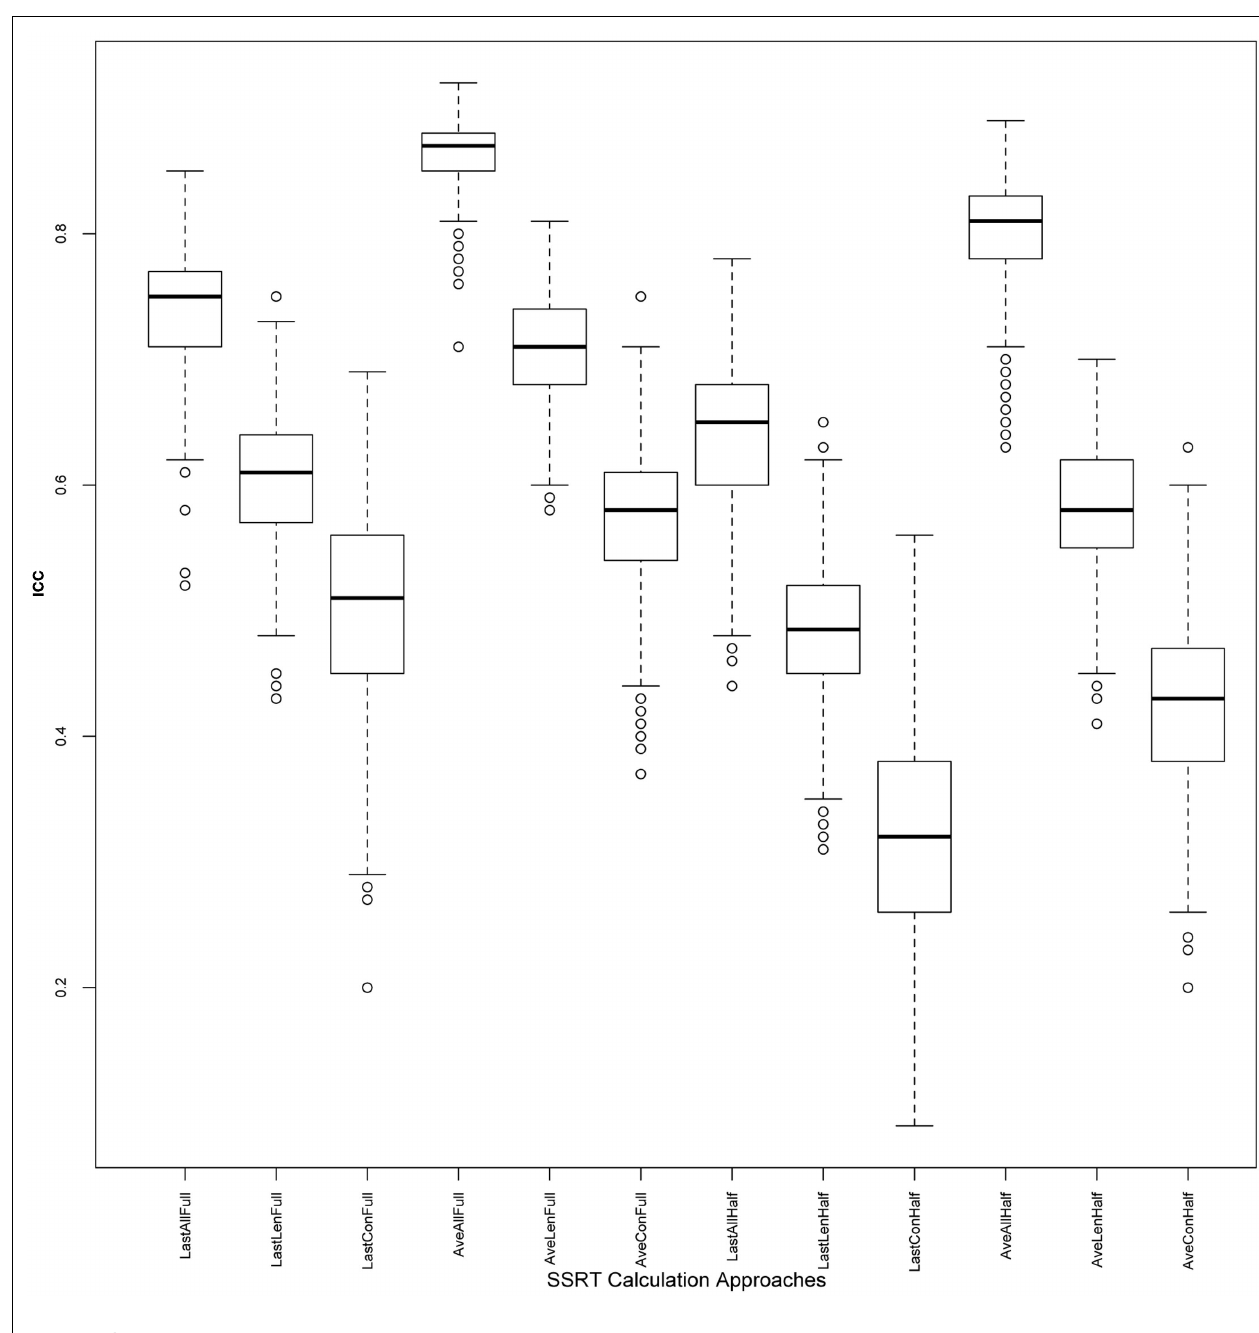
FIGURE 3 | ICC values across iterations: boxplots illustrating distribution of ICC values, for each of the 12 approaches, across 500 iterations. ICC, intra-class correlation coefficient; SSRT, stop-signal reaction